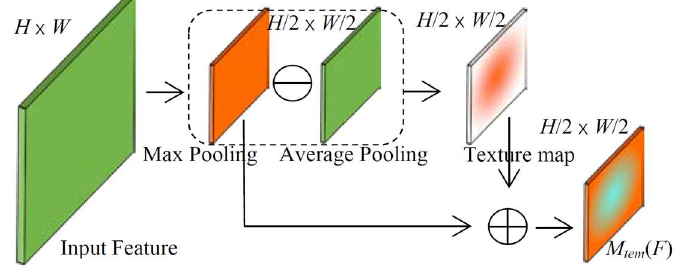
Figure 8. Structure of texture feature enhancement module.